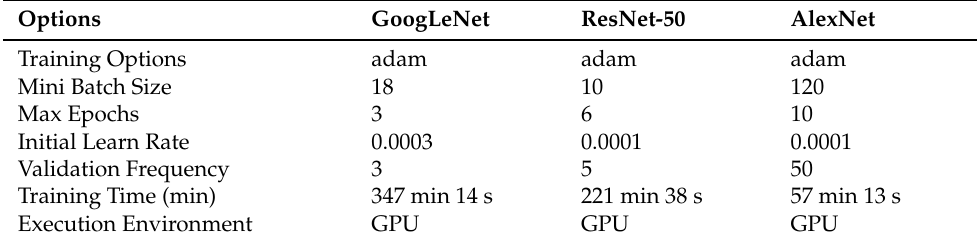
Table 3. Set training options for GoogLeNet, ResNet-50 and AlexNet